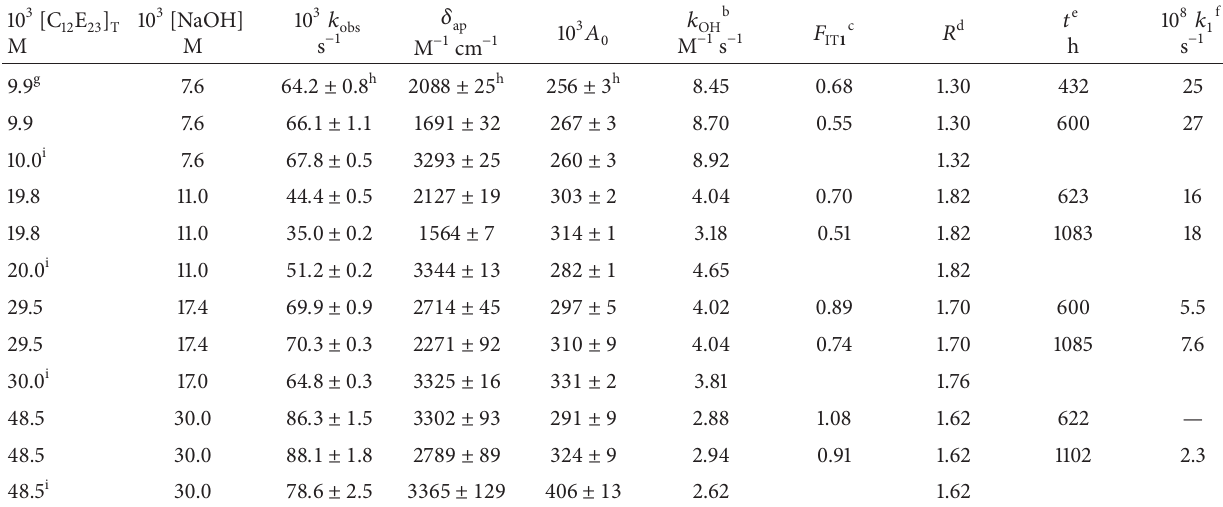
, 𝛿 , and 𝐴 0 calculated from (1) for alkaline hydrolysis of 1 in the presence of C obs ap